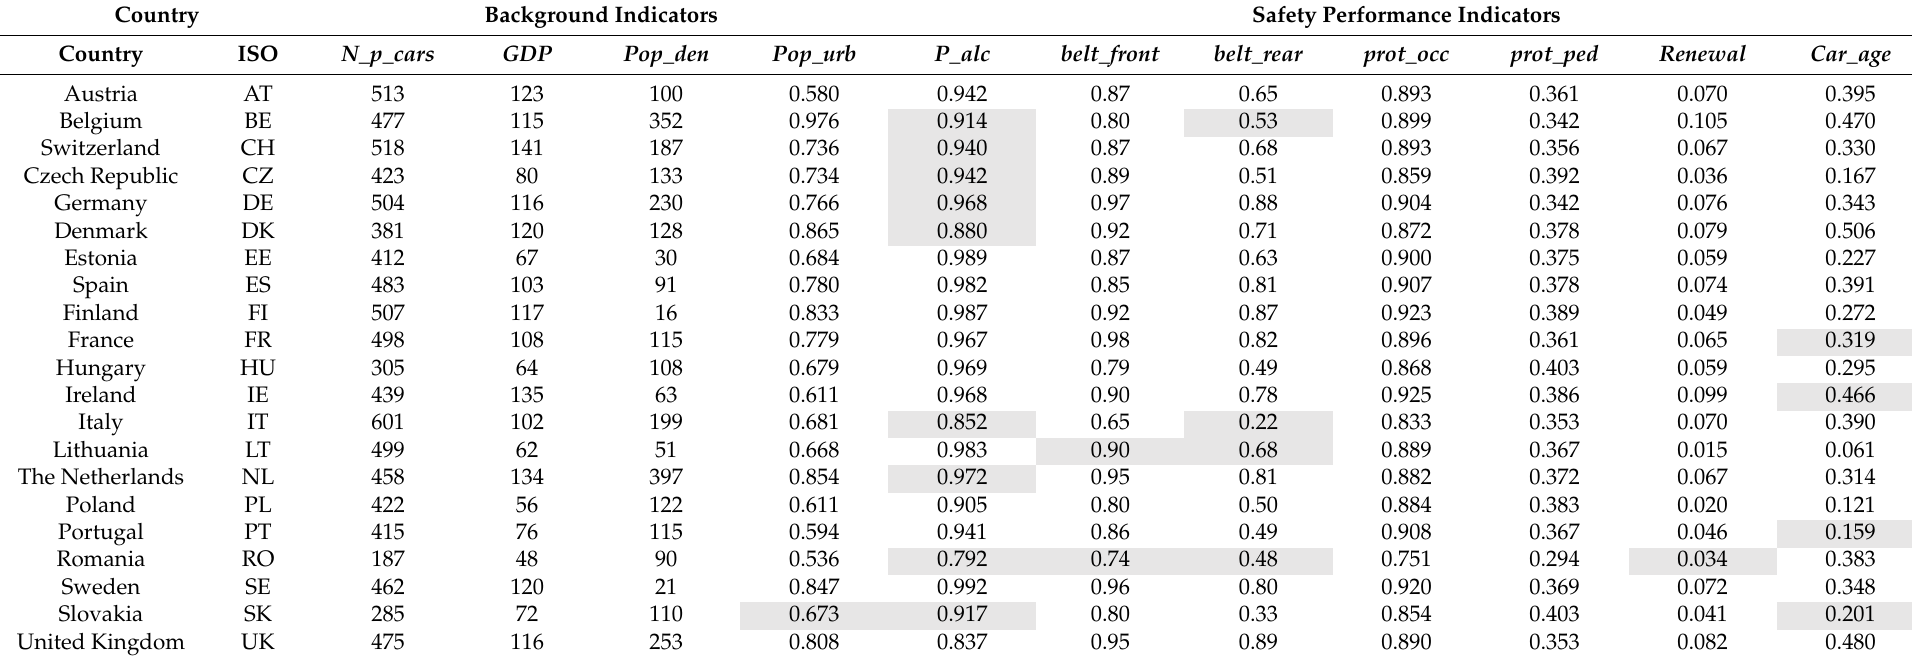
Table A1. Final dataset for 21 European countries (year